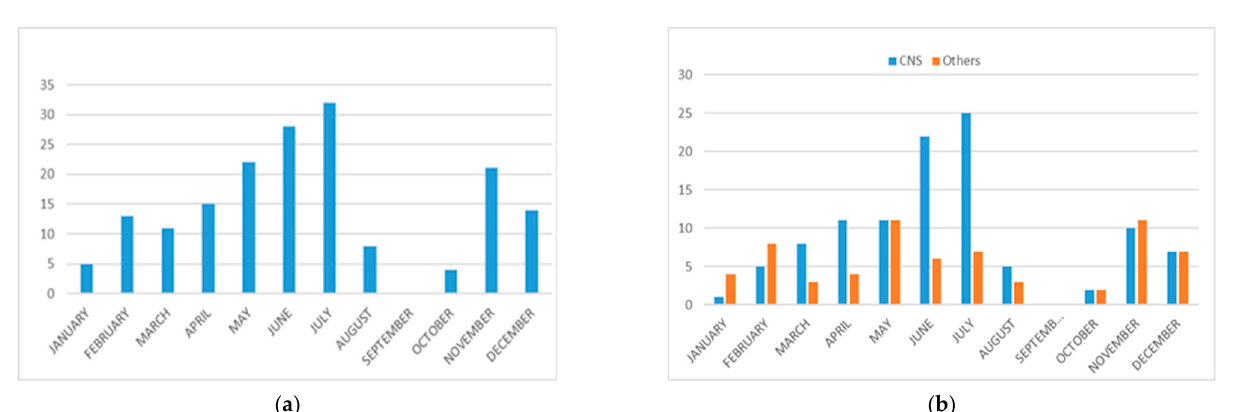
Figure 2. ( a ) Seasonal distribution of all E30 infections included in this study; ( b ) seasonal distribution of E30-positive cases with central nervous system (CNS) diseases versus other clinical presentations.